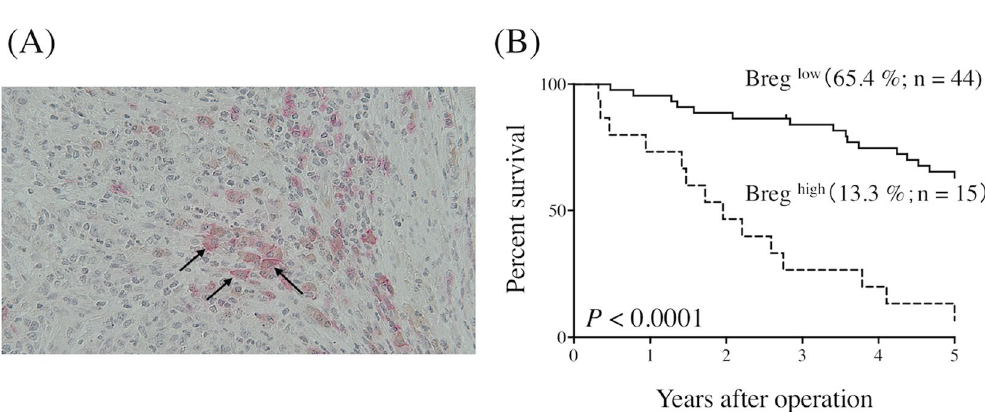
Figure 6. ( A ) Representative image of regulatory B cells (arrows) in gastric cancer tissue following double staining immunohistochemistry (pink, CD19; brown, IL-10; magnification 400 × ). ( B ) The prognosis of patients with a marked infiltration of regulatory B cells was significantly worse than that of those with a slight infiltration of regulatory B cells ( P <